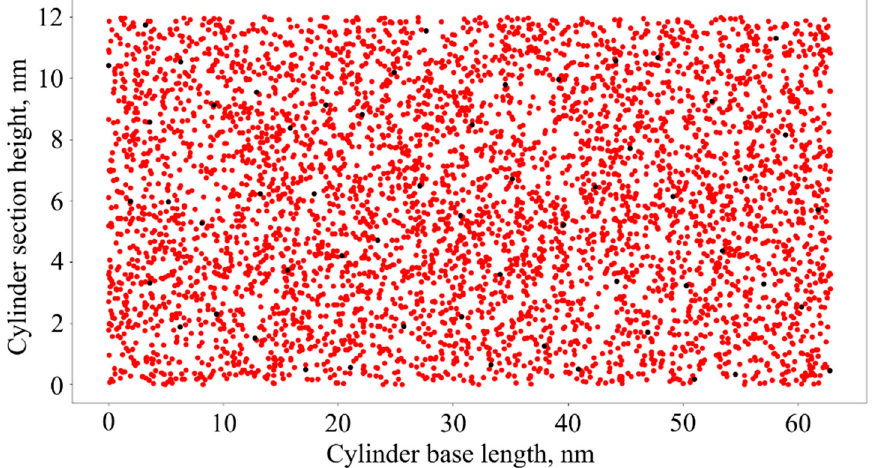
Figure 8. Distribution of particles over the rectangular surface. The rejected particles, the distance to which is less than the minimum (3 nm), are marked in red; the remaining particles are in